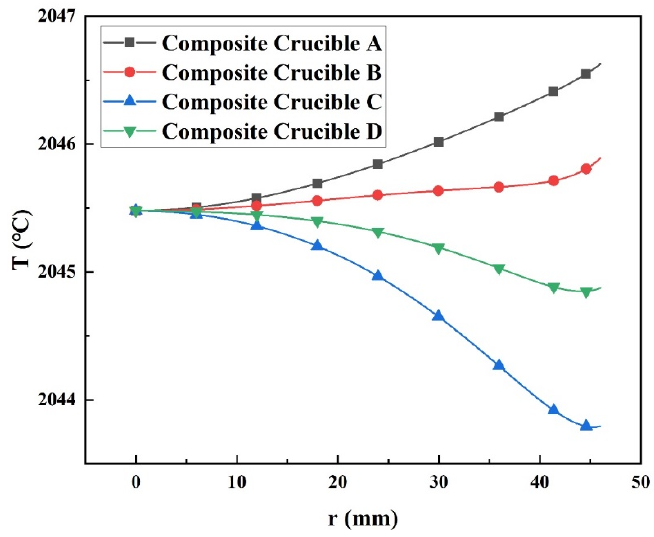
Figure 7. Radial temperature distributions of the AlN crystal horizontal free surface grown in four composite crucibles.